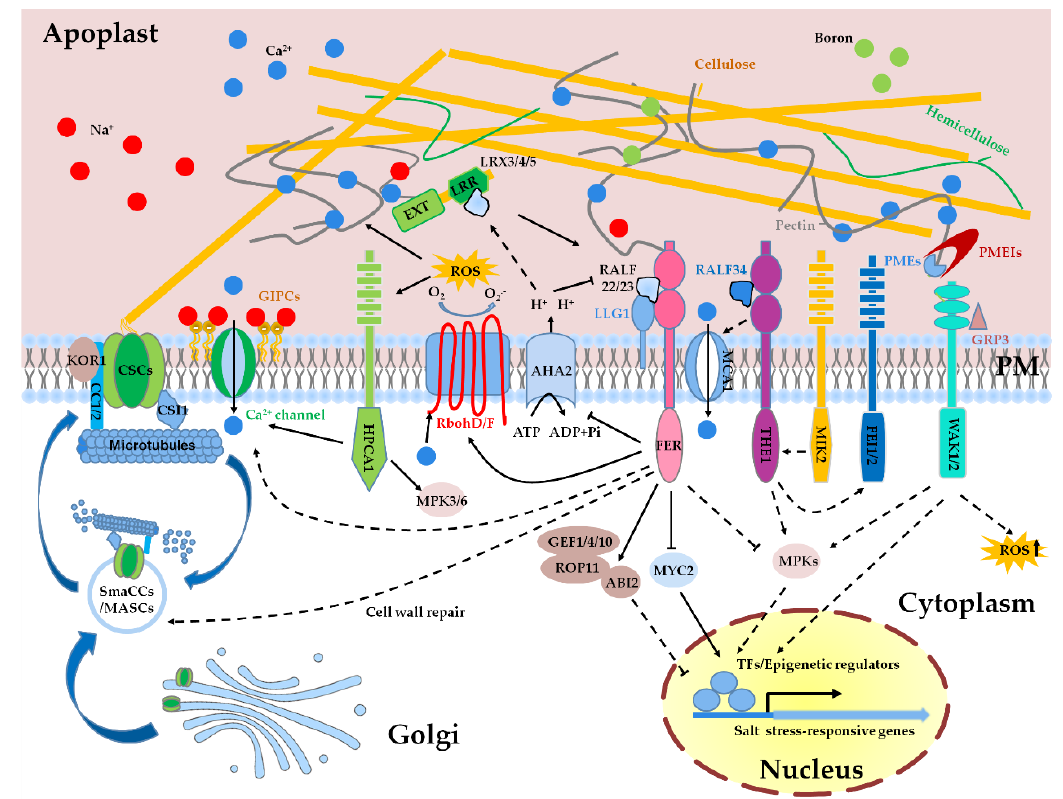
Figure 1. Sensing and maintenance of cell wall integrity under salt stress. Salt stress-induced cell wall changes are proposed to be sensed by multiple receptor-like kinases, including FER, THE1, MIK2, FEI1/2, and WAK1/2. As one of the most important cell wall integrity (CWI) sensors, FER may function alone or together with LRX3/4/5-RALF22/23 module to perceive the perturbation of CWI caused by high salinity. The AHA2-mediated acidification of the apoplastic pH increases the affinity of LRXs with RALFs, while the alkaline state in the apoplast promotes the binding of RALFs with FER. FER and probably also other cell wall sensors convert salt-triggered cell wall signals to multiple intracellular signals, including Ca 2+ , ROS, abscisic acid (ABA), jasmonic acid (JA), and MPKs, which in turn regulate the expression of salt stress-responsive genes in the nucleus. Salt stress can alter the redox status in the apoplast, and RbohD/F-mediated production of the apoplastic H 2 O 2 may affect the cross-linking of cell wall polymers and activate H 2 O 2 sensor HPCA1. Glycosyl inositol phosphorylceramide (GIPC) sphingolipids participate in the sensing of extracellular salt by directly binding to sodium ions. Cell wall biosynthesis- and modification-related components, including pectin methyl esterases (PMEs), PME inhibitors (PMEIs), and cellulose synthase (CesA), are involved in the regulation of salt tolerance in plants. Upon initial exposure to salt stress, cortical microtubules are depolymerized and cellulose synthase complex (CSC) together with its companions CSI1 and CC1/2 are internalized into small CesA compartments/microtubule-associated CesA compartments (smaCCs/MASCs). At the growth recovery stage after salt application, FER is probably required for the regulation of the reassembly of cortical microtubules and the relocation of CSCs to the plasma membrane to synthesize cellulose, which subsequently enhances the adaptation of plants to salt stress. Solid lines represent direct regulations, and dashed lines represent in-direct or potential regulations.